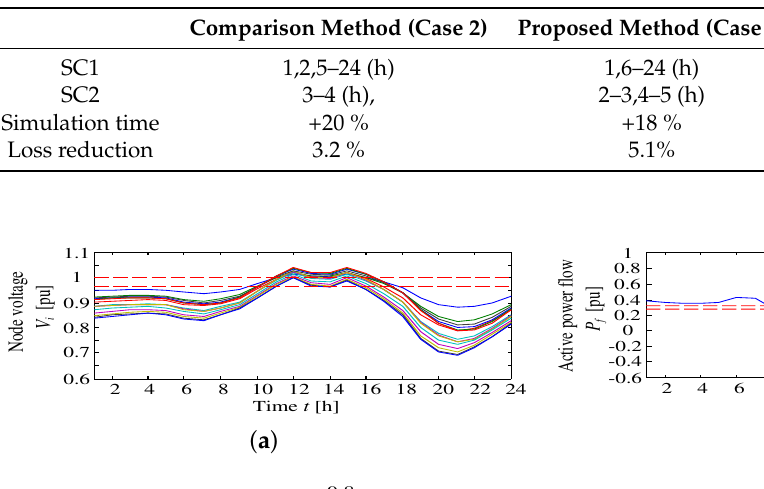
Table 5. Comparison of the scheduling scheme.